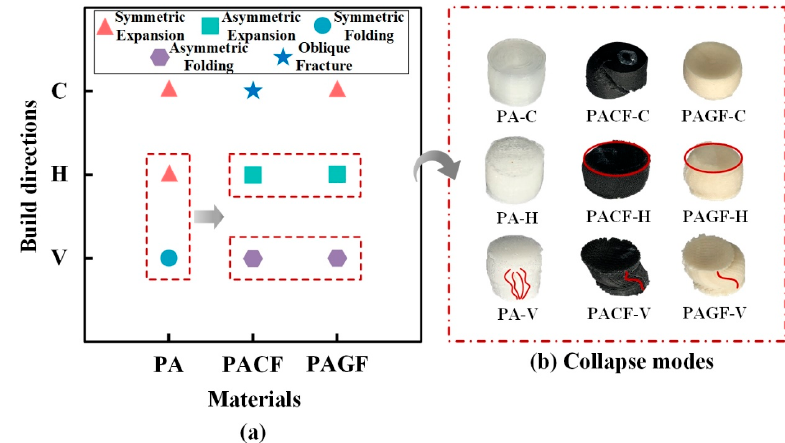
Figure 9. ( a ) The distribution of collapse modes for different materials built at different directions; ( b ) captures of collapse modes of columns (red ellipses indicate symmetric expansion modes and red lines indicate the folding modes).